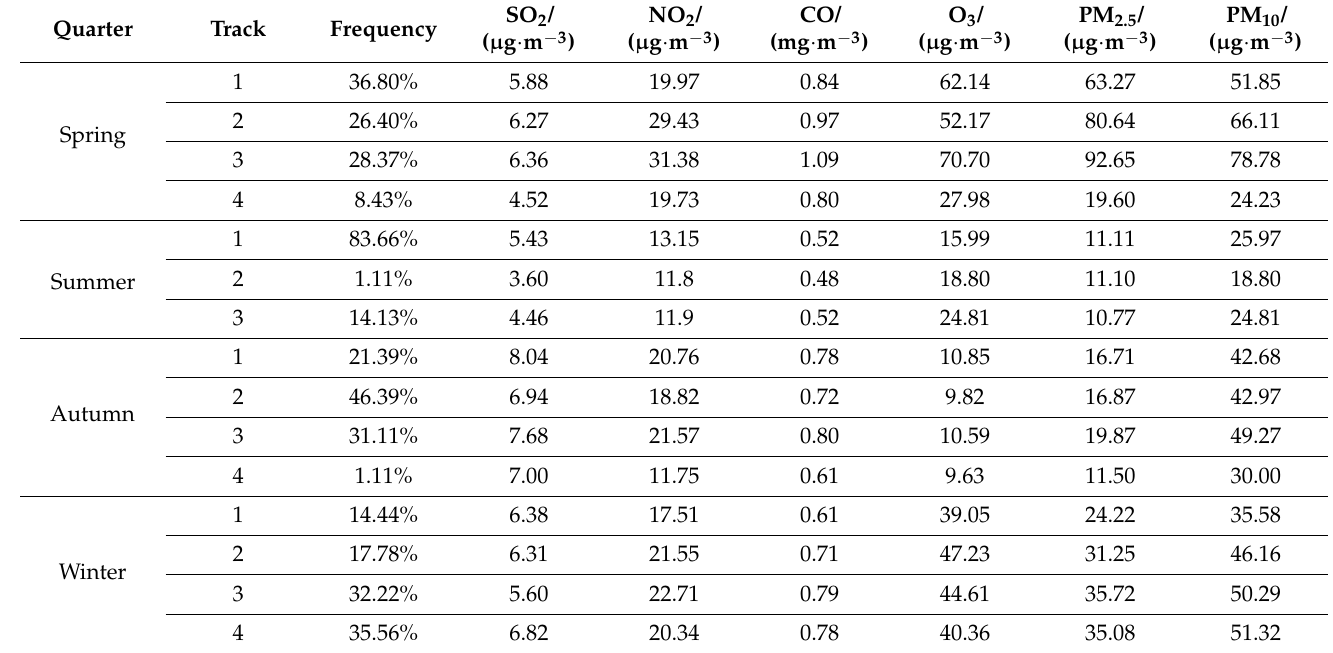
Table 6. Clustering results of four-season backward trajectories in Jinghong in 2020 and the accompa- nying average concentrations of pollutants.